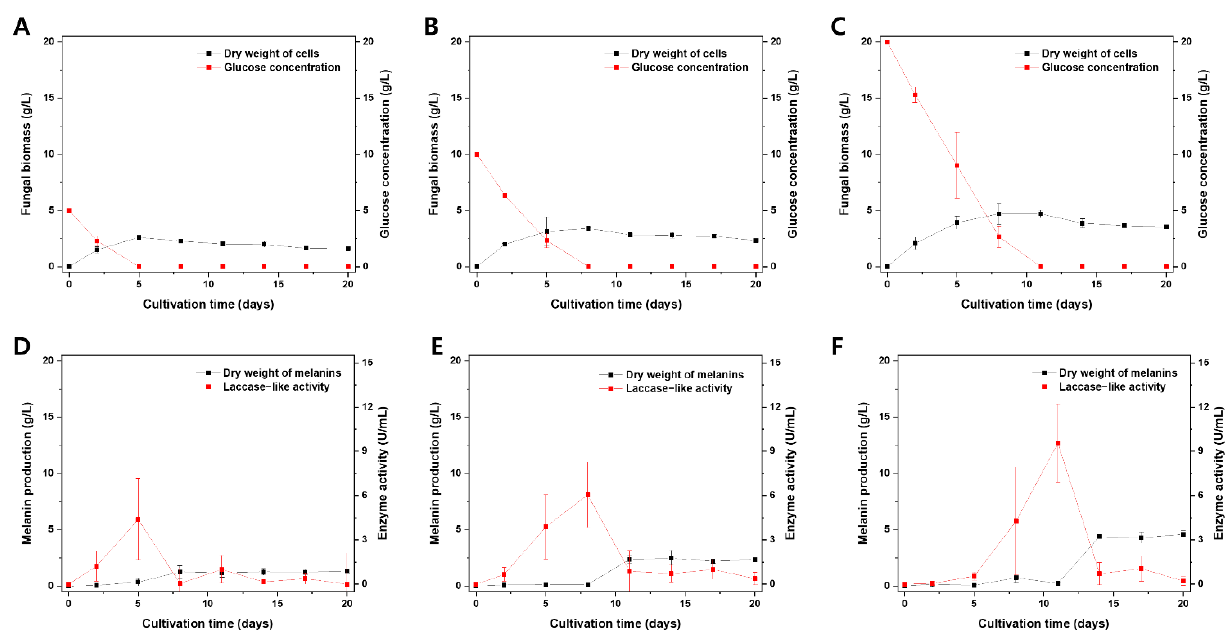
Figure 5. Effect of initial glucose concentration on the A . resinae cultivation profile. Fungal biomass and glucose concentration of media when cultivated at an initial glucose concentration of ( A ) 5 g/L, ( B ) 10 g/L, and ( C ) 20 g/L. Melanin production and laccase-like activity in culture filtrate when cultivated at an initial glucose concentration of ( D ) 5 g/L, ( E ) 10 g/L, and ( F ) 20 g/L.